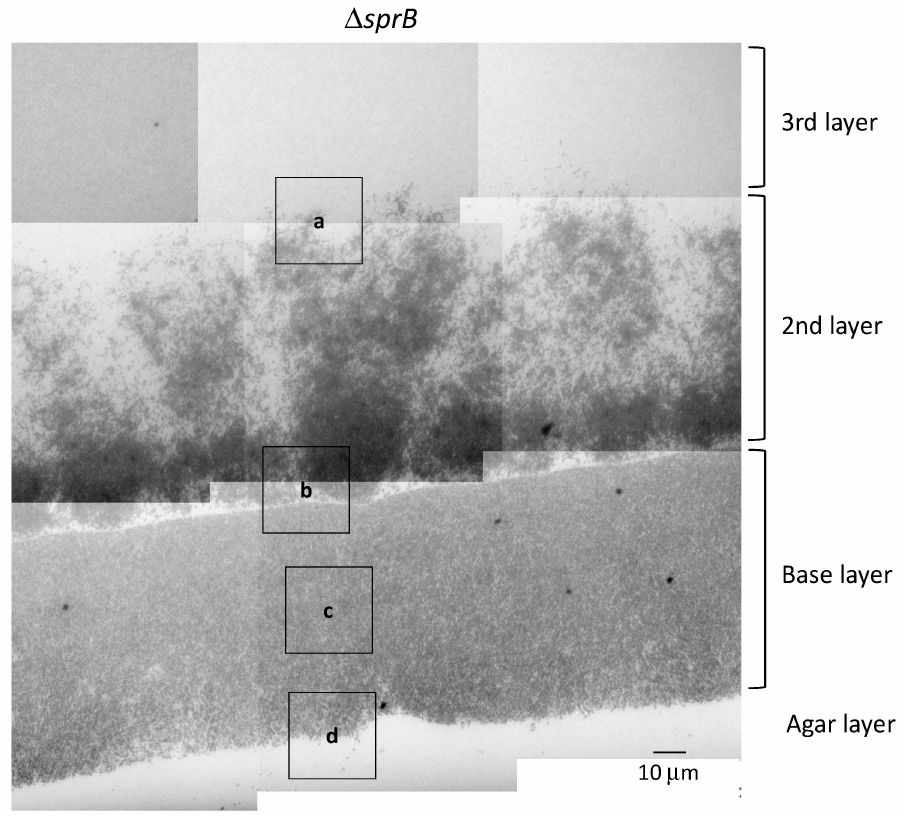
Figure 5. TEM of spreading colonies of the F. johnsoniae ∆ sprB mutant on 1% A-PY2. Colonies of ∆ sprB were aldehyde-fixed and embedded in Epon resin. Then, 70 nm-thick sections were cut parallel to the direction of colony growth and perpendicular to the surface of the agar medium (Figure S1b), stained with metal solutions and examined by TEM. Overview of the sections examined. High-magnification images of cells pictured in Figure 5 are shown in Figures 6 and 7 (second